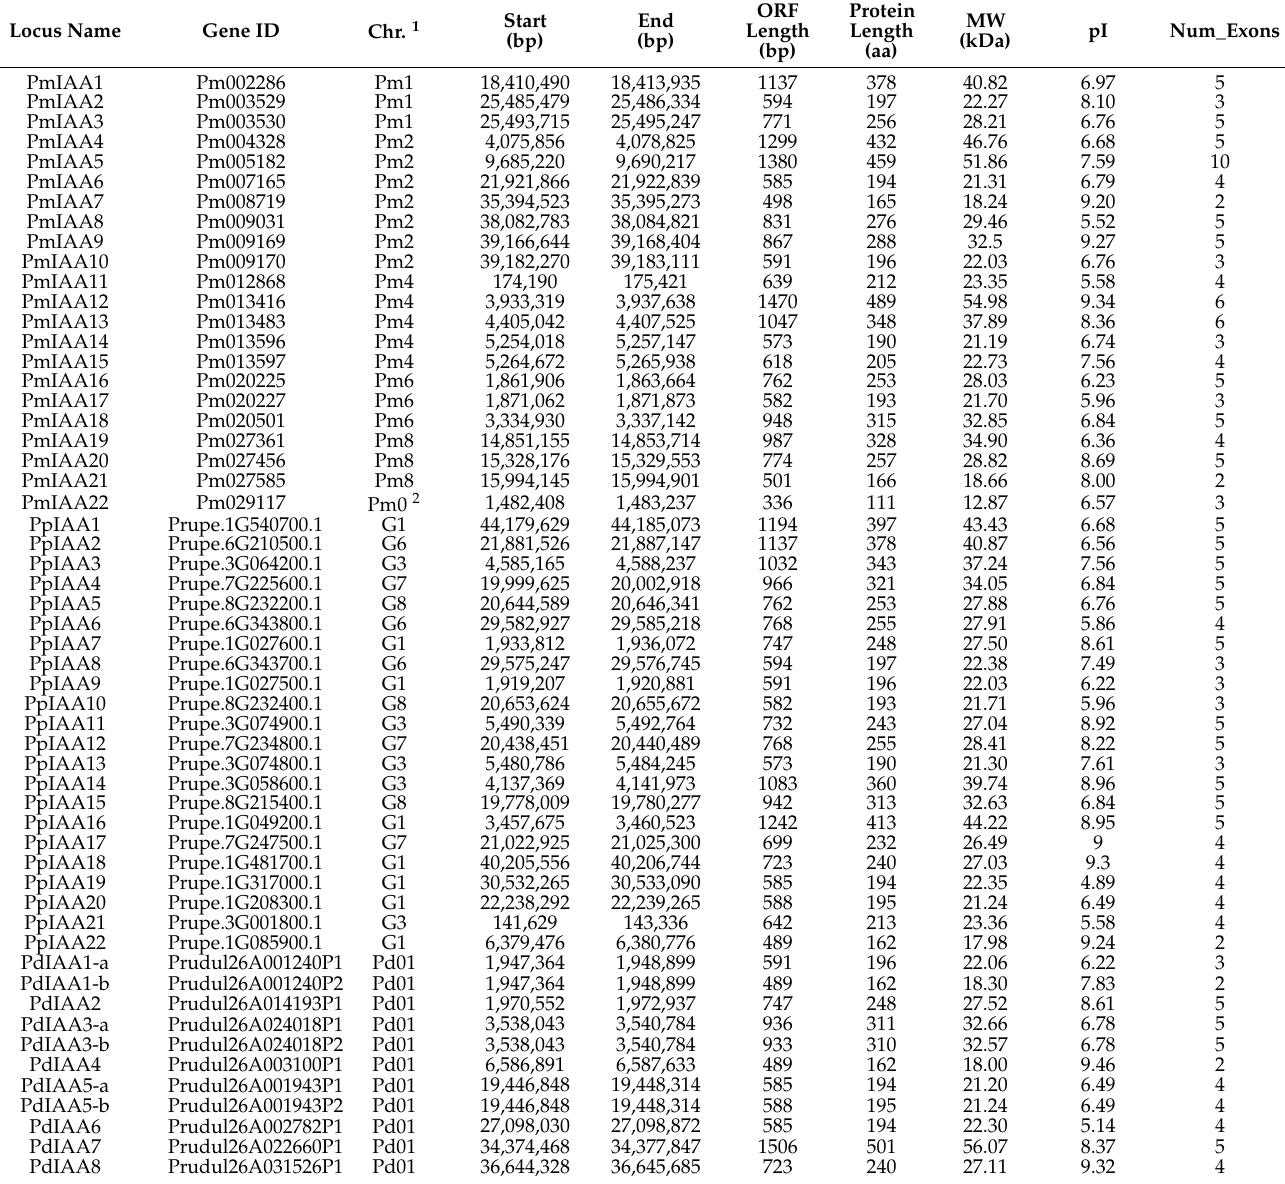
Table 1. Characteristics of Aux/IAA family members in four Rosaceae plants